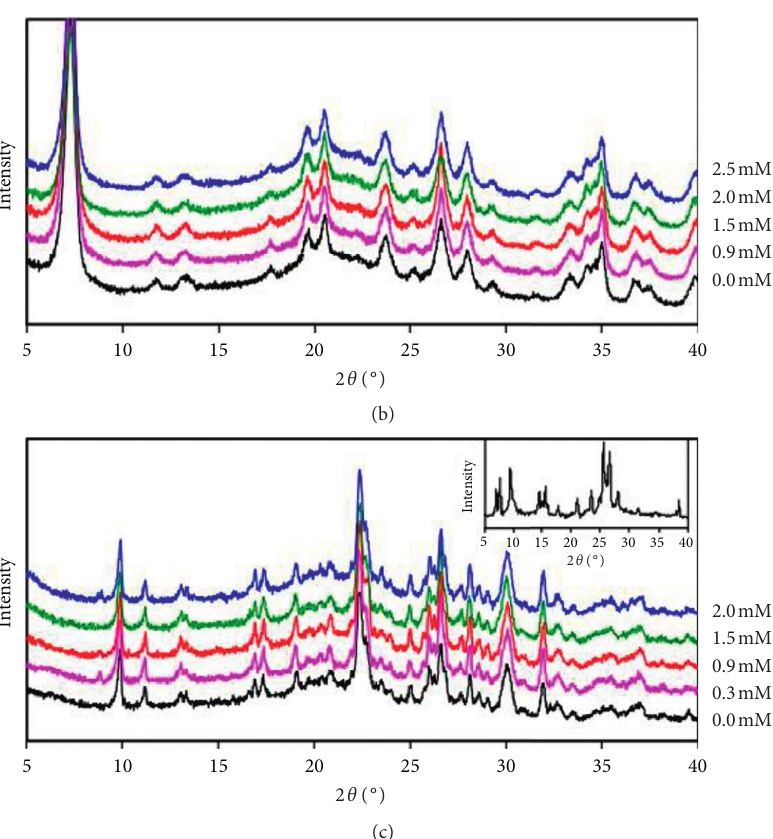
Figure 4: XRD patterns of PAL (a), SEP (b), and ZEO (c) after SO uptake from different initial SO concentrations. The inset in (c) is the XRD pattern of crystalline SO.